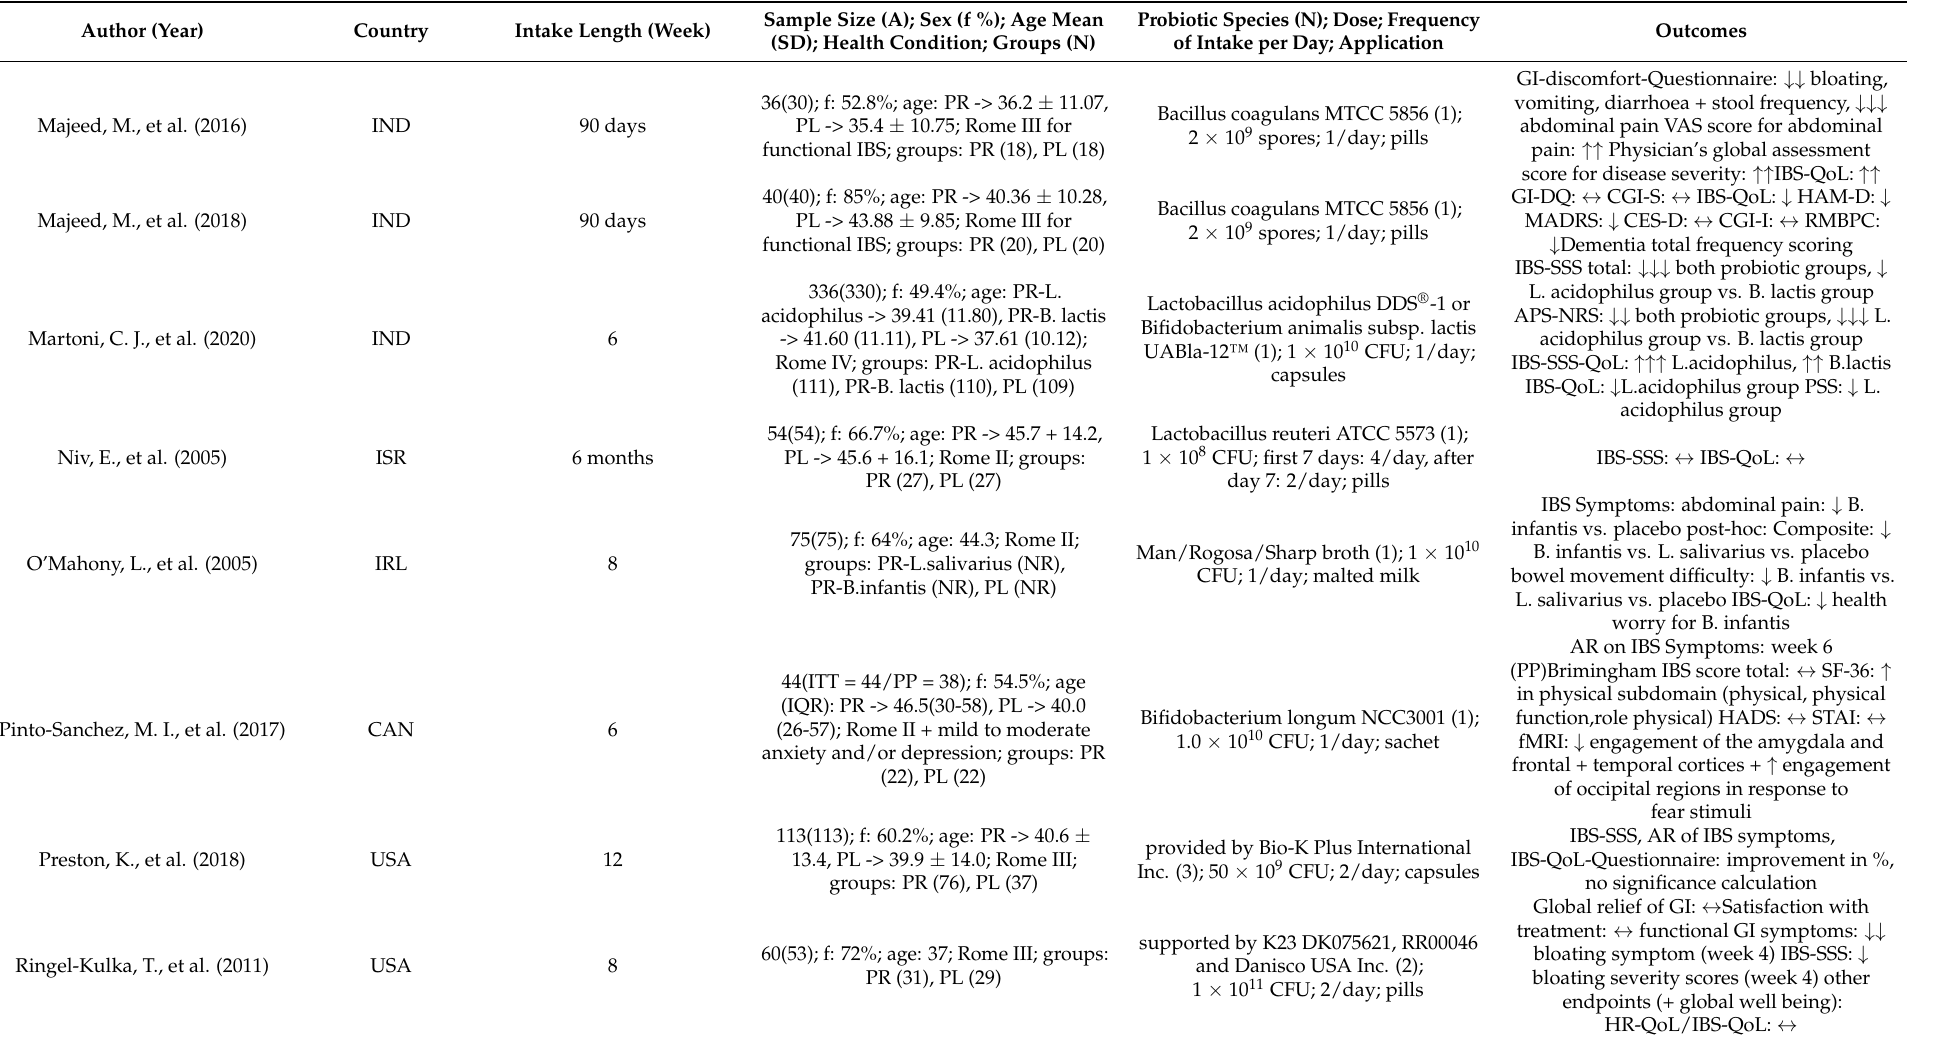
B. infantis vs. L. salivarius vs. placebo bowel movement difficulty: ↓ B. infantis vs. L. salivarius vs. placebo IBS-QoL: ↓ health worry for B.